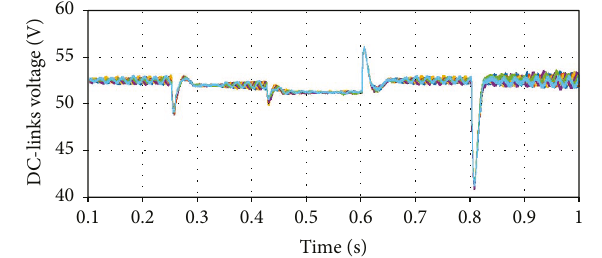
Figure 29: Variations in DC-link voltages in response to the changes in solar radiation.